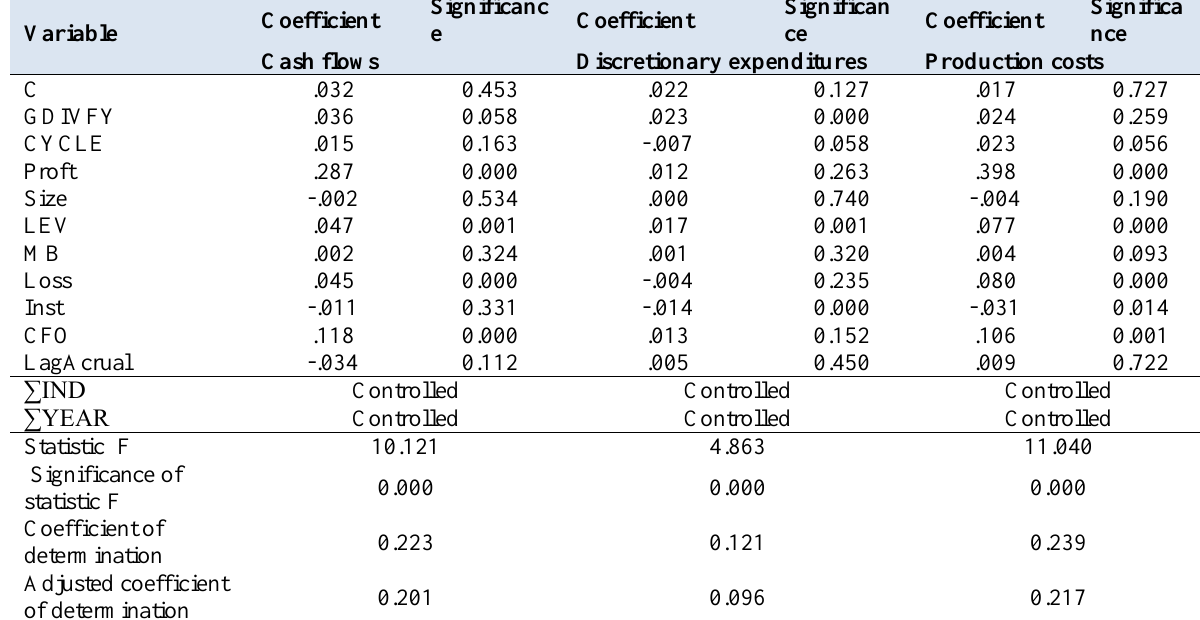
0.000 0.000 0.000 0.223